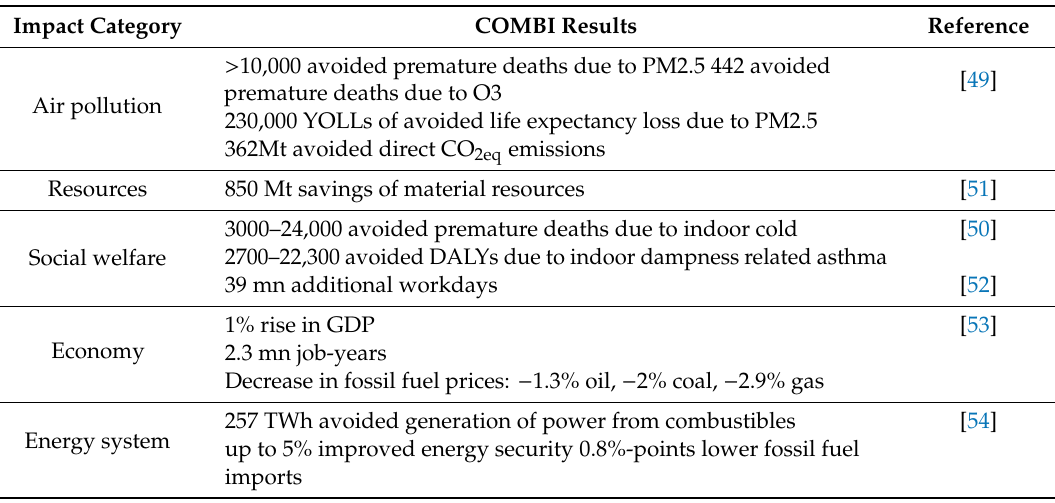
Table 3. Impacts in physical terms by category (annual values in the year